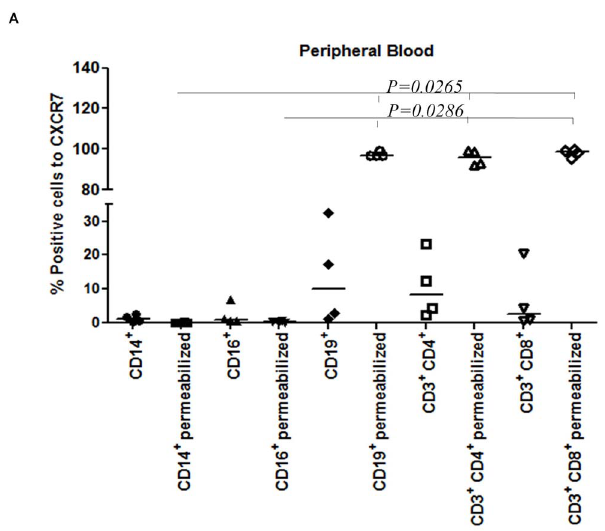
Figure 9. High CXCR7 expression of peripheral blood and bone marrow lymphocytes. (A) CXCR7 is expressed in peripheral blood leukocytes, however an increase in CXCR7 cell surface expression was observed in lymphocytes compared to monocytes and neutrophils. This difference was more apparent and significant when the cells were permeabilized (lymphocytes vs. monocytes, P=0.0265 and lymphocytes vs. neutrophils, P=0.0286 ) showing that the localization of this receptor is mainly intracellular in B-lymphocytes, CD4 + T-lymphocytes and CD8 + T-lymphocytes; Mann-Whitney test.